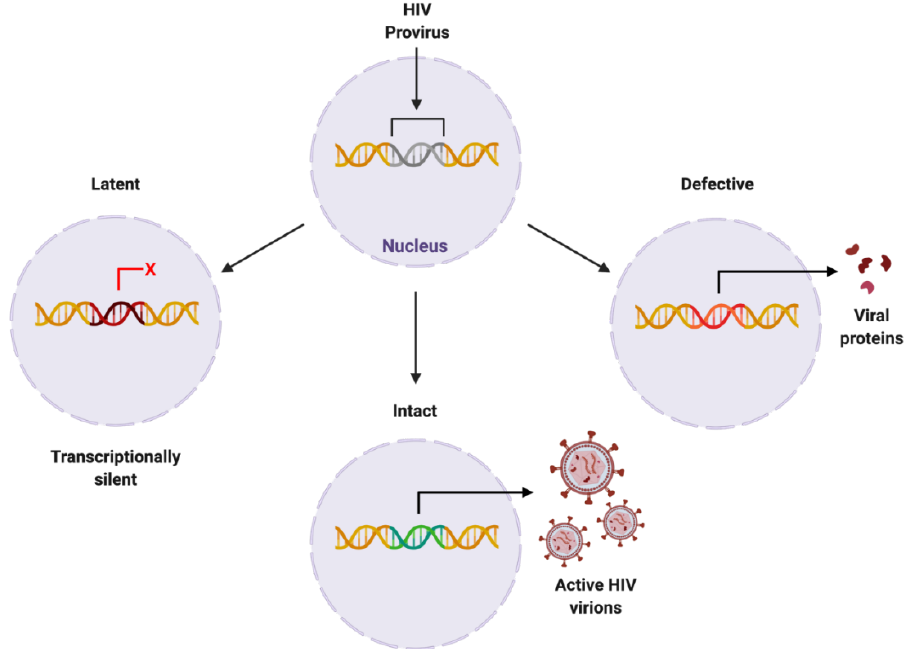
Figure 4. Proposed forms of HIV proviral reservoir. HIV provirus can persist in three forms: latent, being transcriptionally silent; intact, producing active HIV virions; or defective, containing genetic mutations resulting in viral protein synthesis. Created with BioRender.com. Abbreviations: HIV = human immunodeficiency virus.